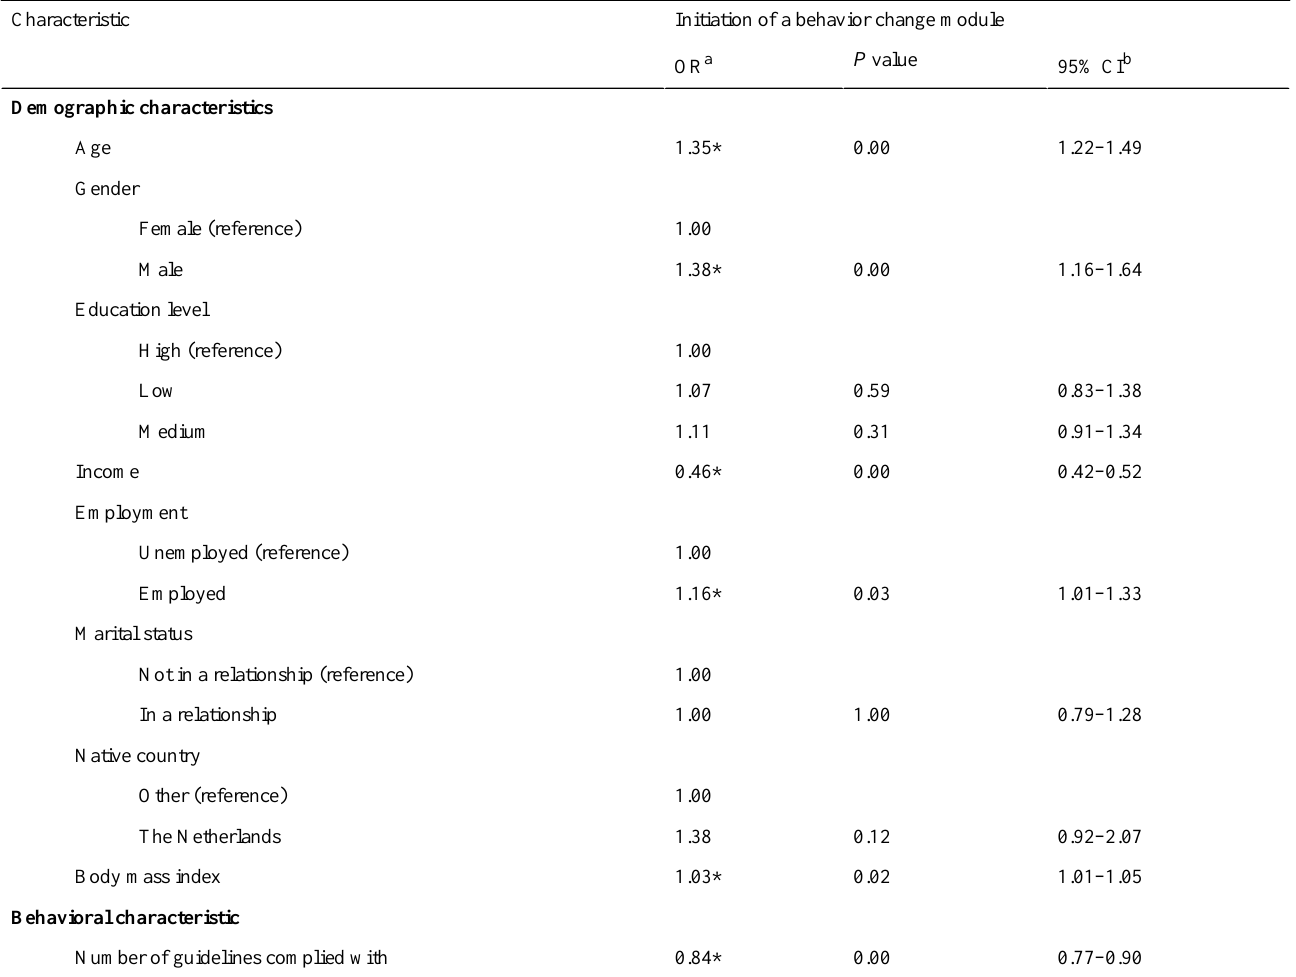
Table 2. Results of multivariate logistic regression analyses of demographic characteristics, behavioral characteristic, and intention, with initiating a behavioral computer-tailored module as dependent variable (n =